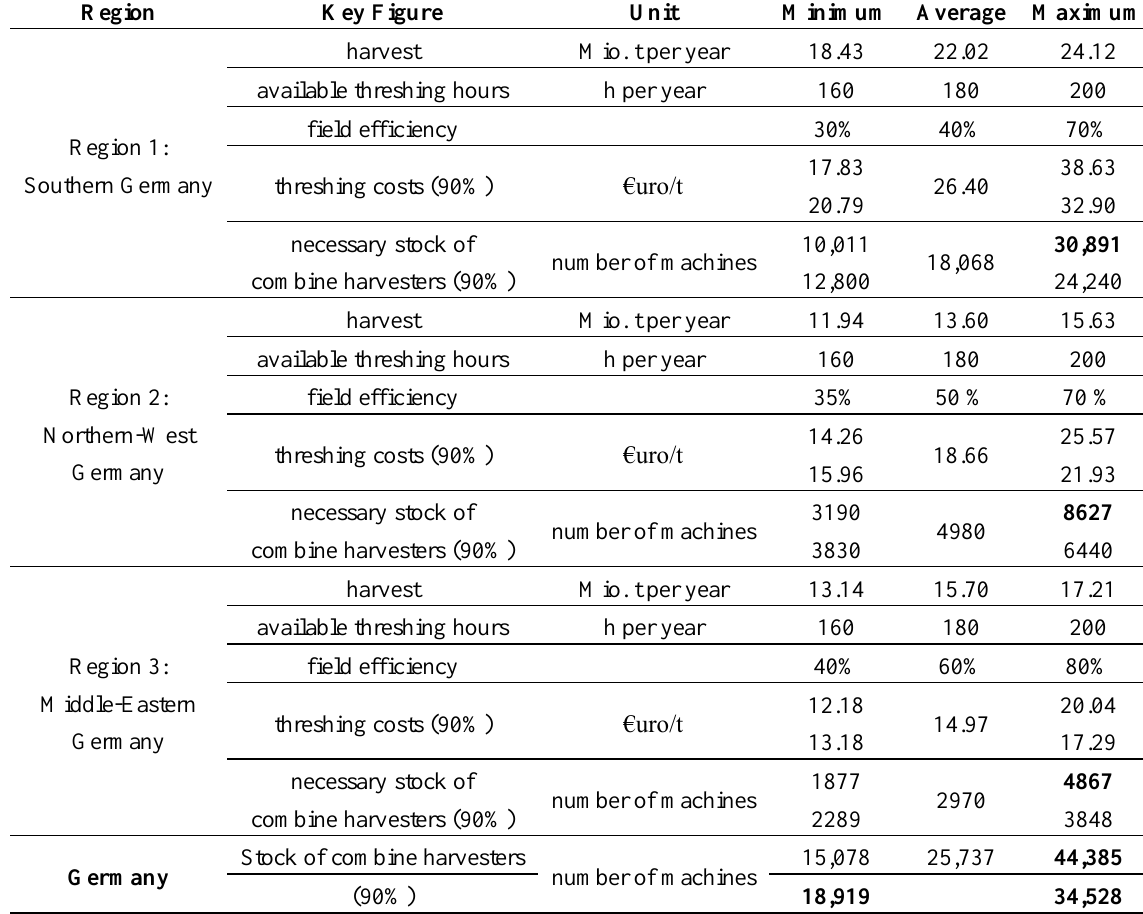
Table 4. Assumptions (minimum, medium and maximum values of the triangle distributions) and simulation results (in the 90% range). Unit Minimum Average